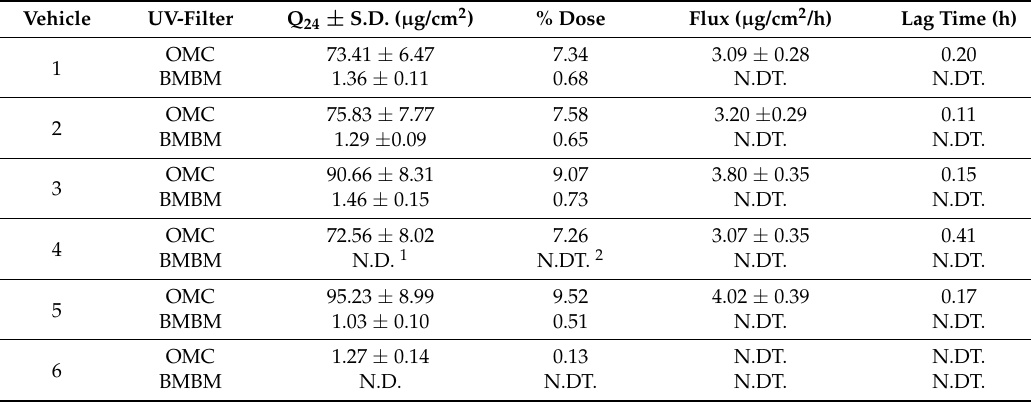
Table 4. In vitro release of OMC and BMBM from vehicle 1–6: cumulative amount released after 24